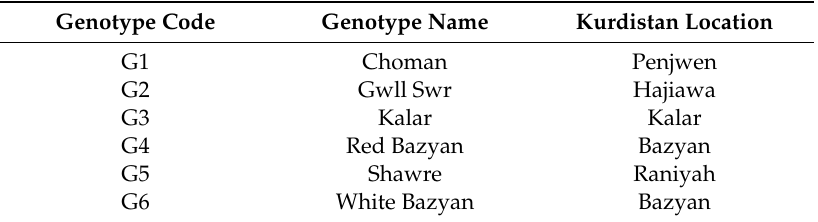
Table 1. Name and location of di ff erent rice genotypes used in the